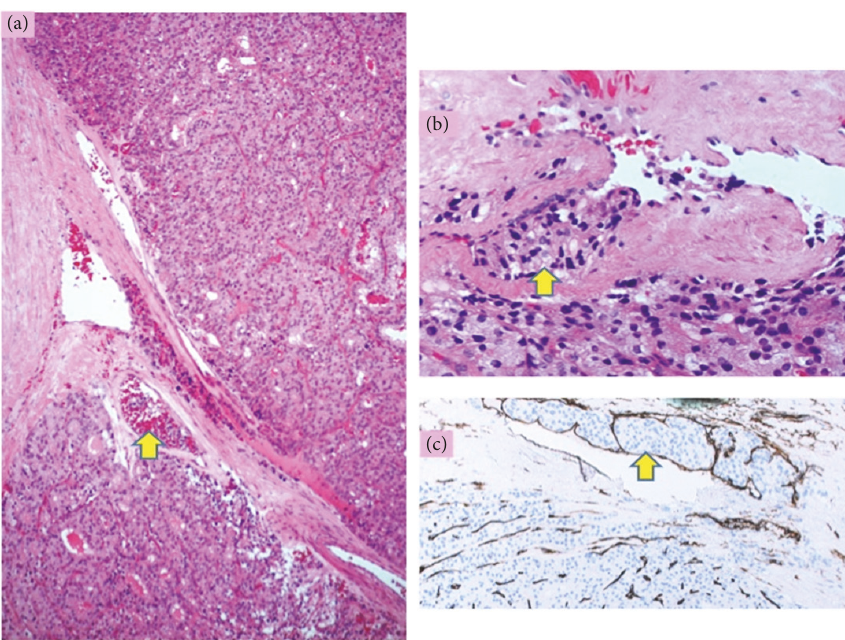
Figure 2: (a) Tumour and a capsule with a vessel containing tumour cells, arrow (H&E, x80); (b) tumour cells aggregate within the vessel lumen of the capsule (HE, x360); (c) intravascular tumour cell aggregate covered by endothelial cells (CD34, x100).